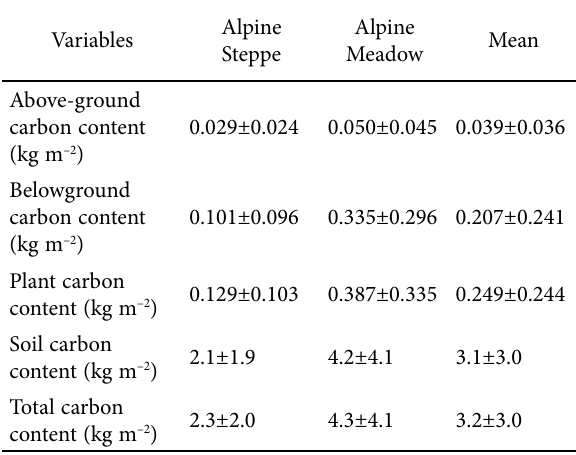
Table 1. Plant and soil carbon contents of alpine steppe and alpine meadow grasslands in Tibetan Plateau